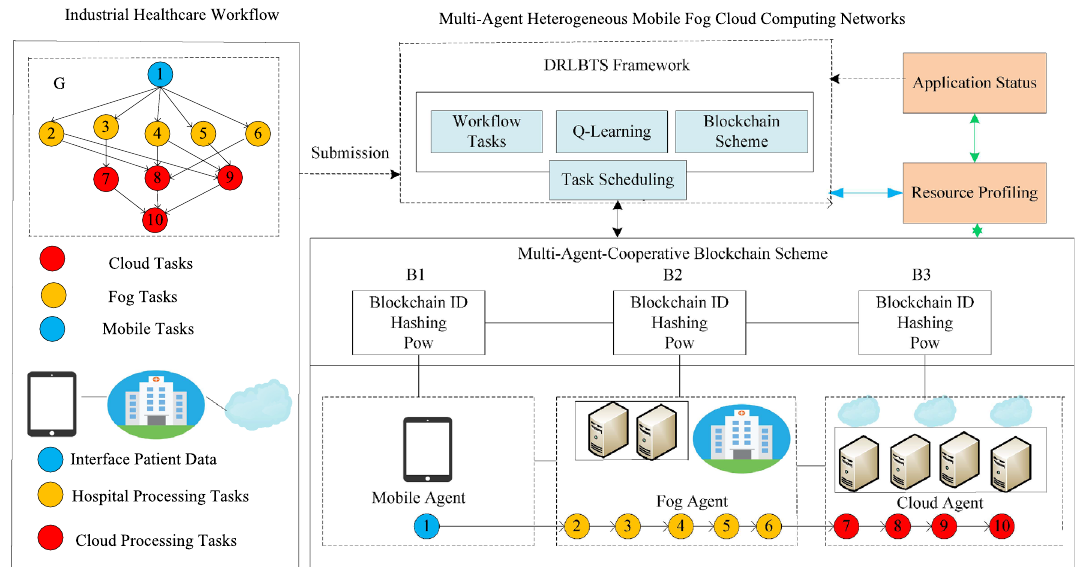
Figure 1. DRLBTS: deep reinforcement learning-aware blockchain-based healthcare